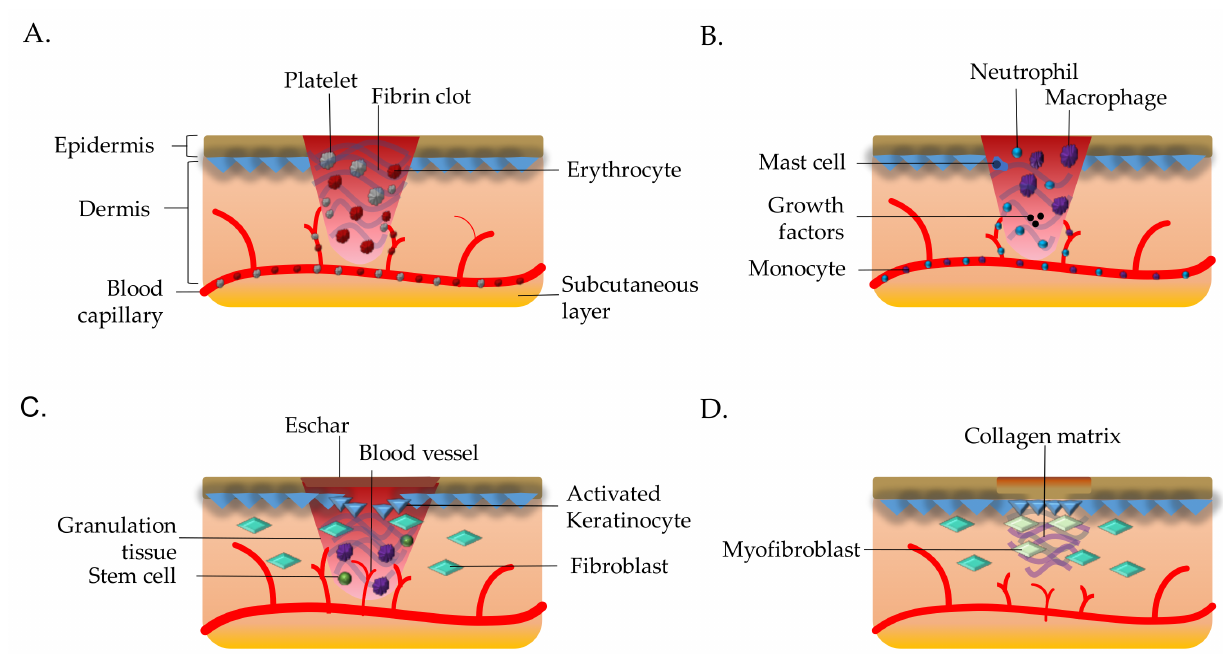
Figure 1. The myriad of wound healing processes. ( A ) Hemostasis process involves excretion of platelet to reduce the blood loss and formation of preliminary matrix (fibrin clot). ( B ) Inflammation involves the inflammatory cells to fight infection and debris removal. ( C ) Proliferation process where keratinocytes migrate to reduce the wound gap, fibroblasts proliferation replaces initial fibrin clot with granulation tissue and formation of new blood vessels occurs. ( D ) Remodeling phase causes the wound contraction that initiated by fibroblasts and myofibroblasts. Adapted with permission [8]. Licensed under CC BY